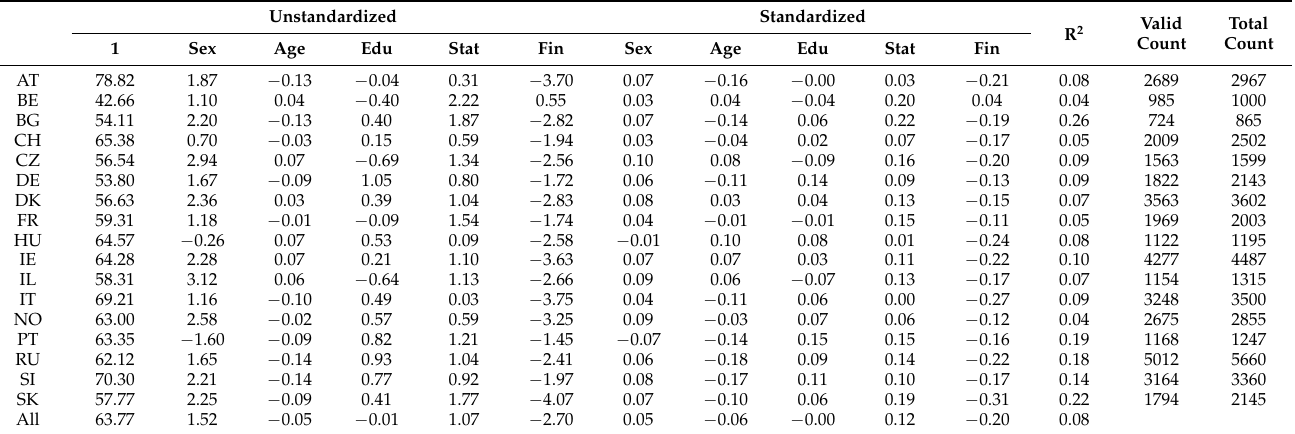
Table 14. Multivariable linear regression models of the type P score by five core social determinants (standardized coefficients ( β ) and R 2 ), for each country and for all countries (equally weighted).